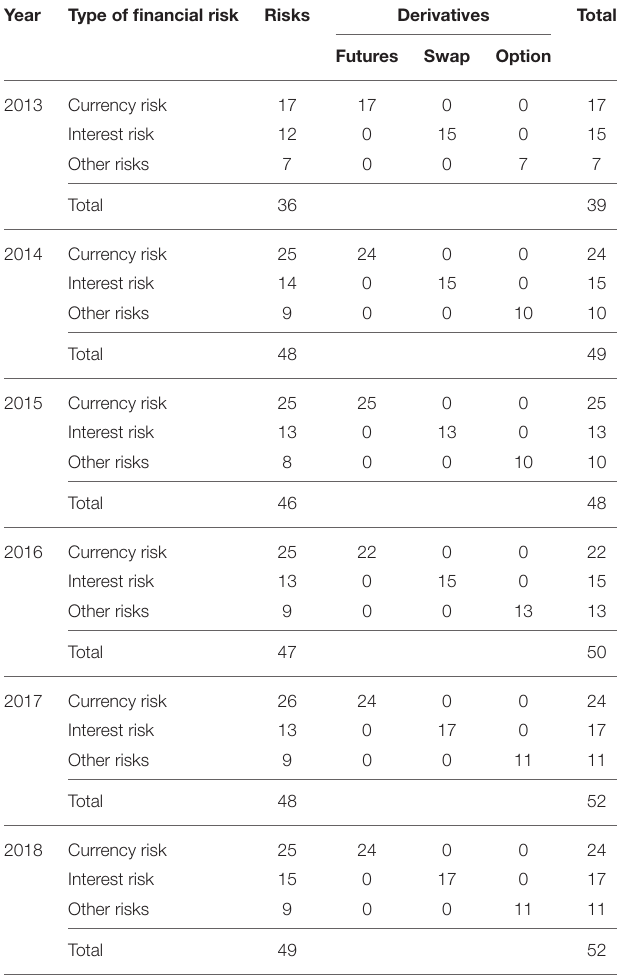
TABLE 8 | Risks of companies between 2013 and 2018 and derivatives used for these